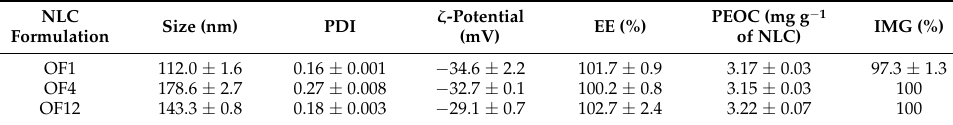
Table 4. Size, polydispersity index (PI), zeta potential ( ζ -potential), entrapment efficiency (EE), Palmarosa essential oil content (PEOC), and inhibition of mycelial growth (IMG) of the optimized formulations (OF) containing